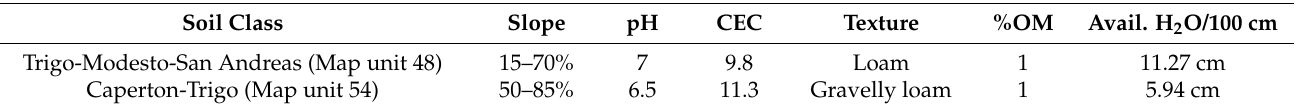
Table 2. Soil classifications, soil physical and chemical properties are specified for the Gold Creek Preserve according to USDA historical data